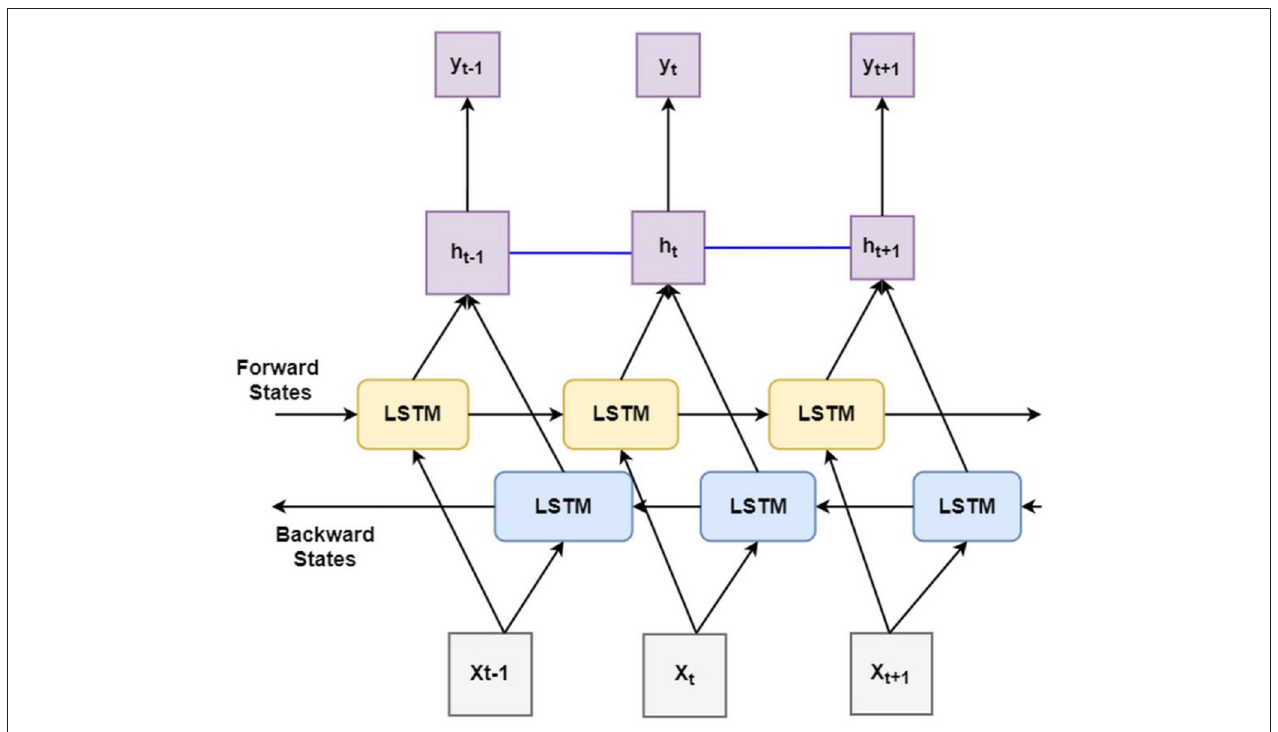
FIGURE 2 | Block diagram of bidirectional long short-term memory learning (BiLSTM): A BiLSTM, is a serial sequence learning model that consists of two LSTMs operating in two directions effectively increase the amount of information available to train and test the network. The first LSTM inputs in data in a forward direction, and the second LSTM in a backwards direction. This improved the context available to the learning algorithm helping it to learn the sequence of the time series data, i.e., what data immediately follows (X t + 1 ) and precedes (X t − 1 ) the events of interest such as the seizure (X).